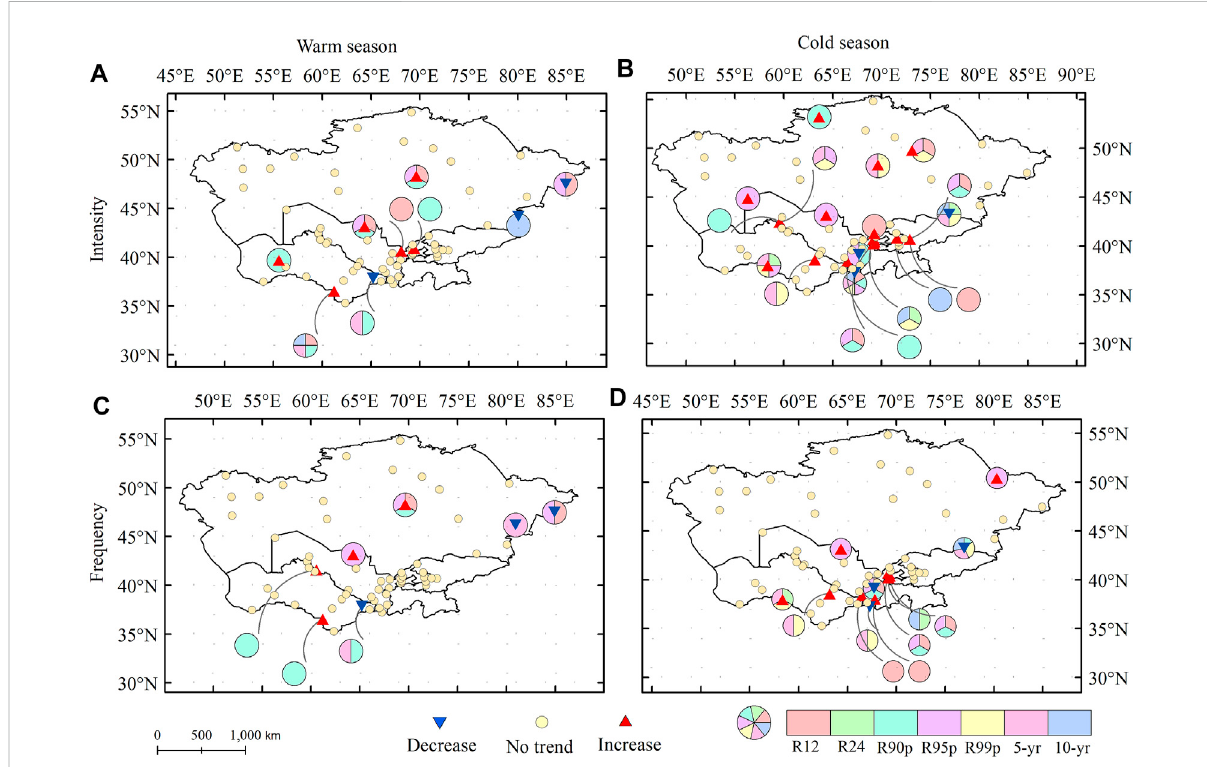
FIGURE 6 Spatial map for intensity (A,B) and frequency (C,D) of extreme precipitation trend with signi fi cance in Central Asia from 1985 to 2005. (The pie: threshold criteria that exhibited the same signi fi cant trend and its amounts; trend: at a signi fi cance level of 10% by the MK test).